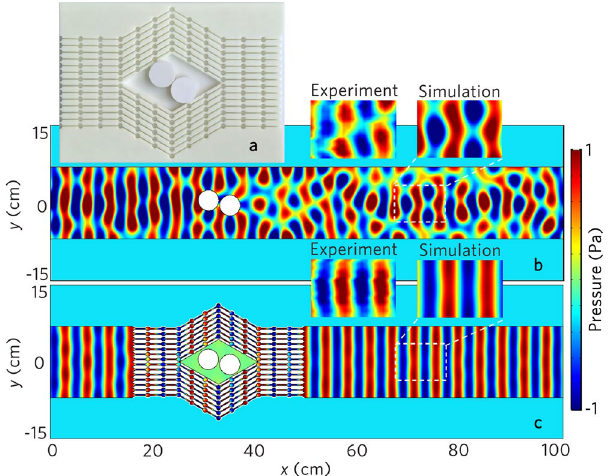
Figure 5. Acoustic shifter. ( a ) Photograph of the designed acoustic shifter. Simulation results of the acoustic pressure field distributions ( b ) without and ( c ) with the acoustic shifter illuminated by the normally incident plane wave at 8.0 kHz. Two white circular objects with the radius of 2 cm in ( a – c ) represent the rigid scatterers.